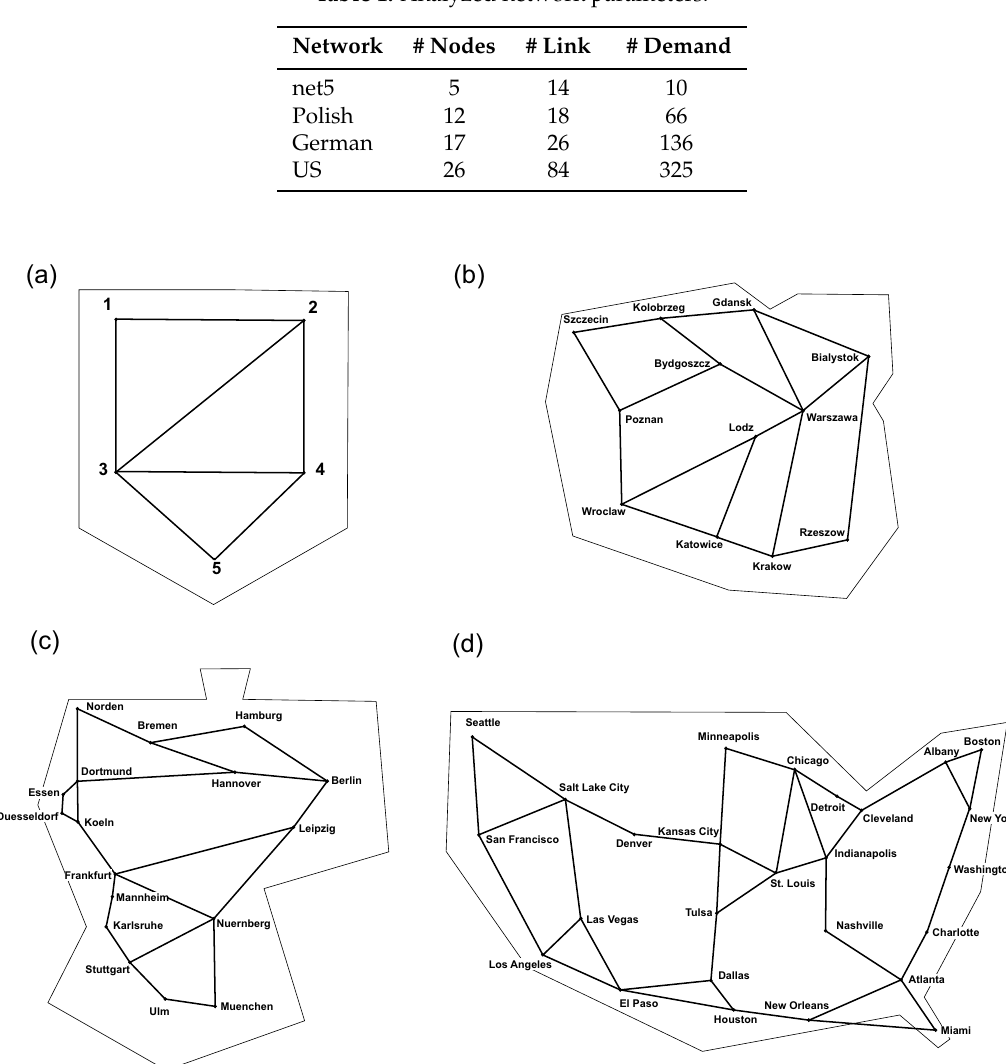
Table 1. Analyzed network parameters.